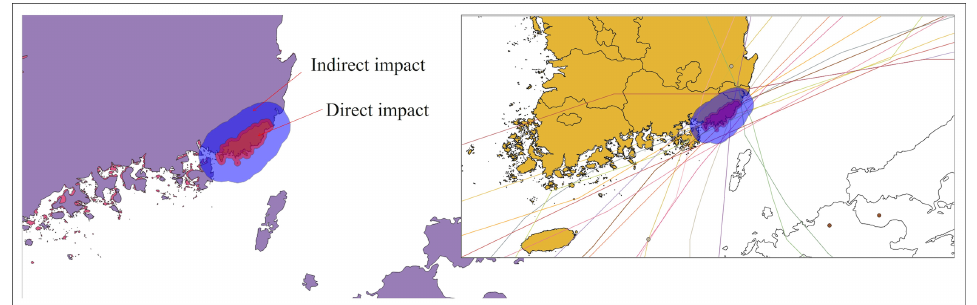
Figure 3. Buffer regions ( left ) and their intersection with typhoon track lines ( right ). The two buffer regions are for indirect and direct impacts on the Busan